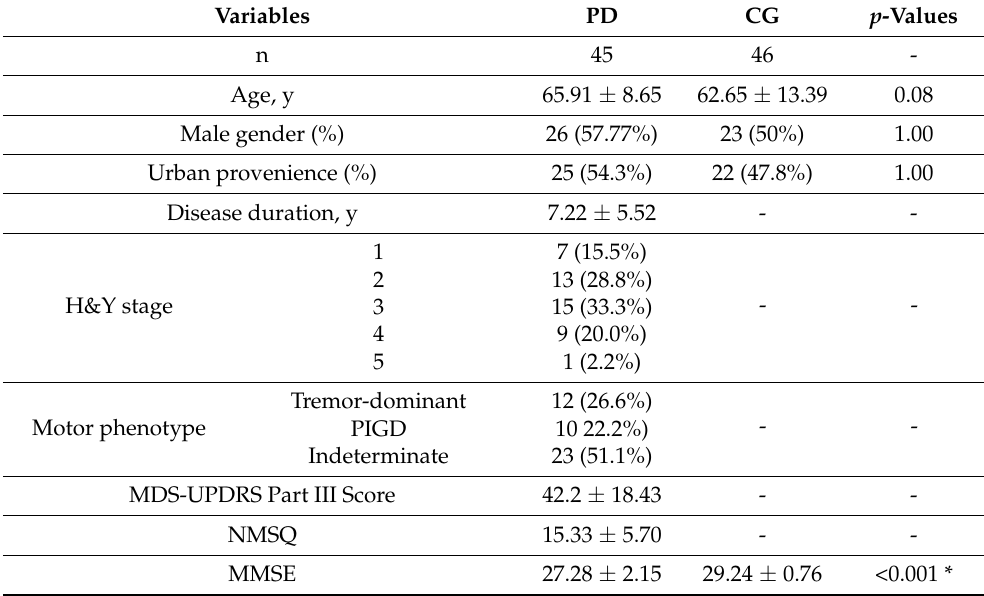
Table 1. Demographics and clinical features of the patients (statistics is given for t -test except for *, where a Mann–Whitney U test is reported).